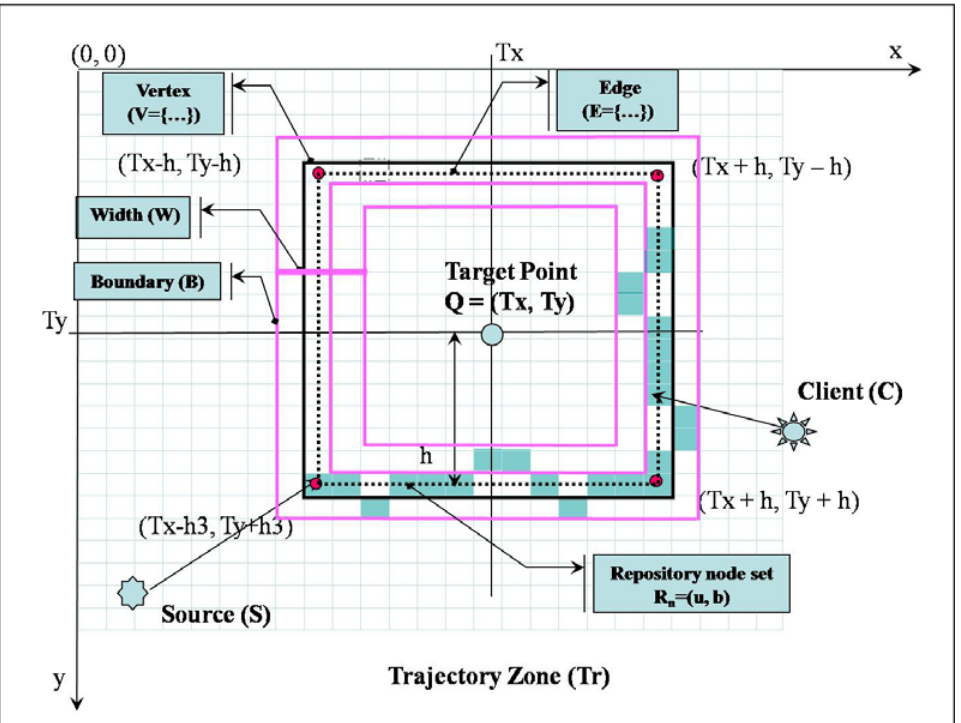
Figure 6. Square-Shaped Trajectory